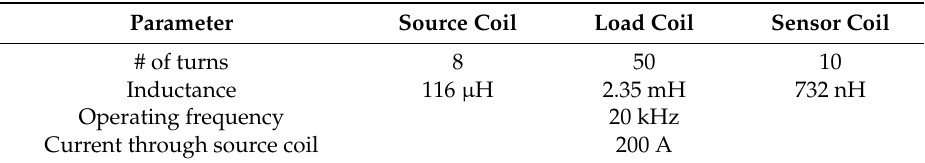
Figure 4. 3-D EM simulation model of the source coil and load coil and their dimensional parameters (in cm). Table 1. Parameter setup for the 3-D EM simulation.